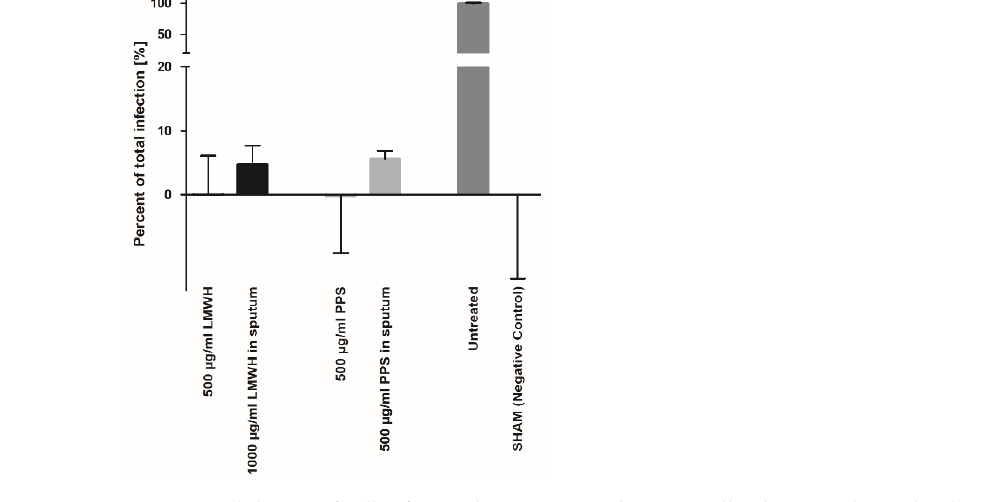
Figure 6. Inhibition of cell infection by LMWH and PPS in cell culture media and in human sputum samples .